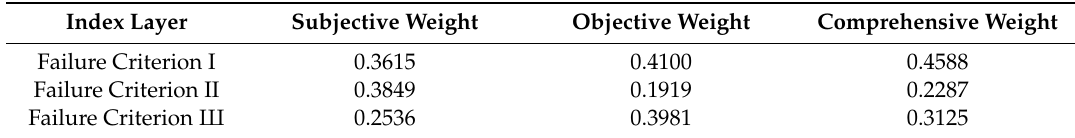
Table 14. The evaluation indexes of bridge system reliability and the weights of